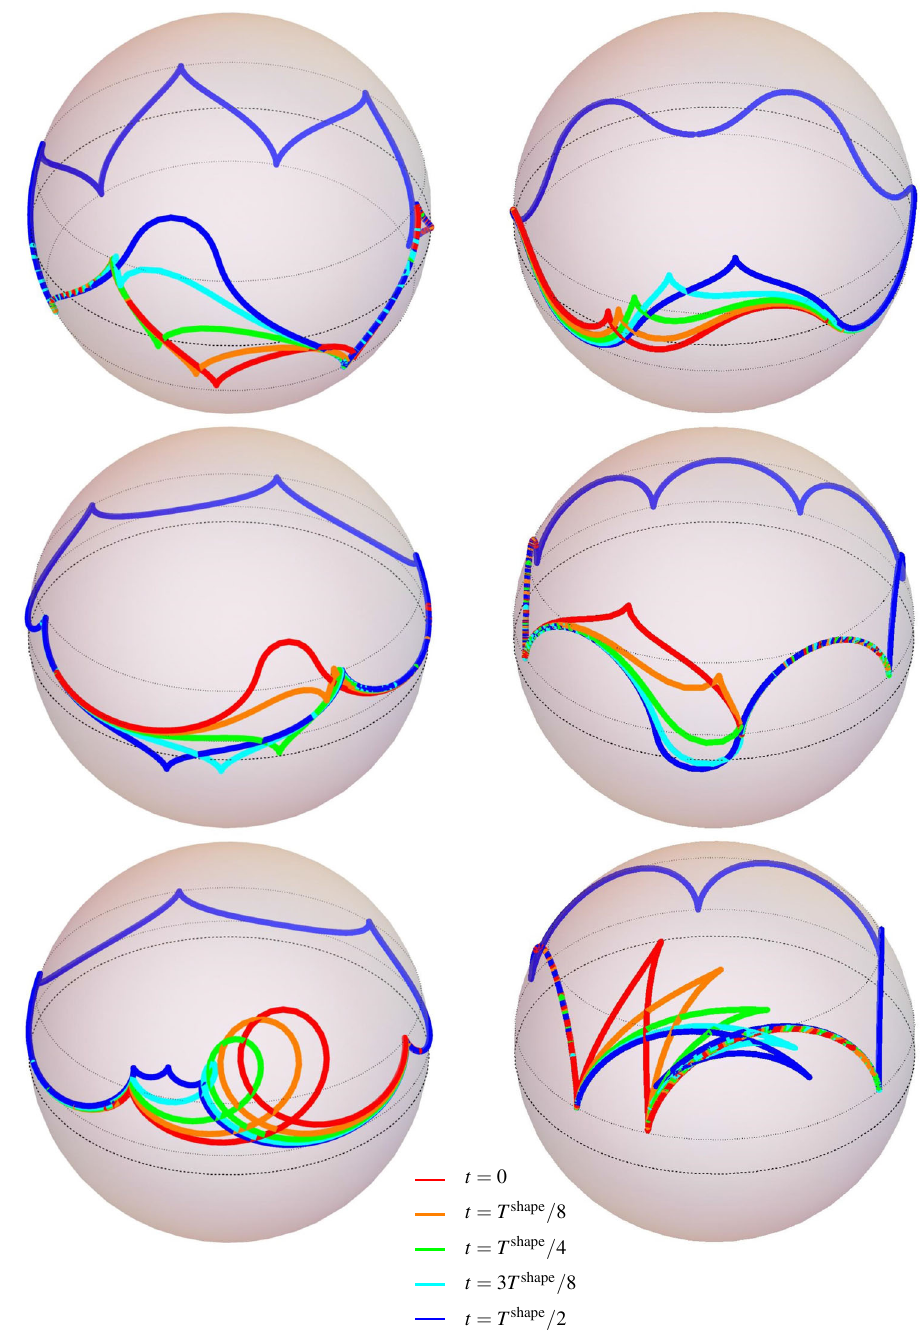
Fig. 20 The time evolution of the dressed elliptic string solutions depicted in Fig.